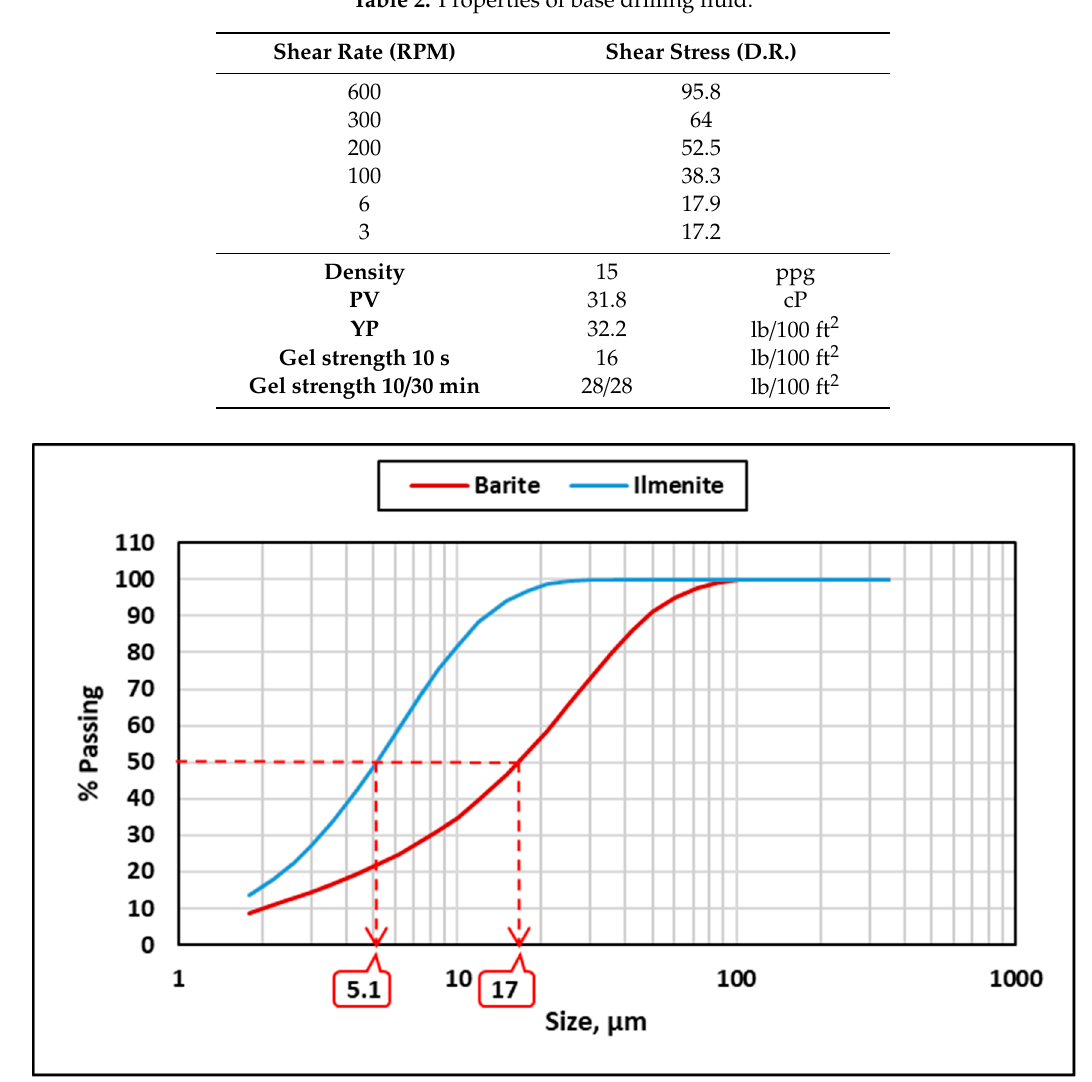
Table 2. Properties of base drilling fluid.